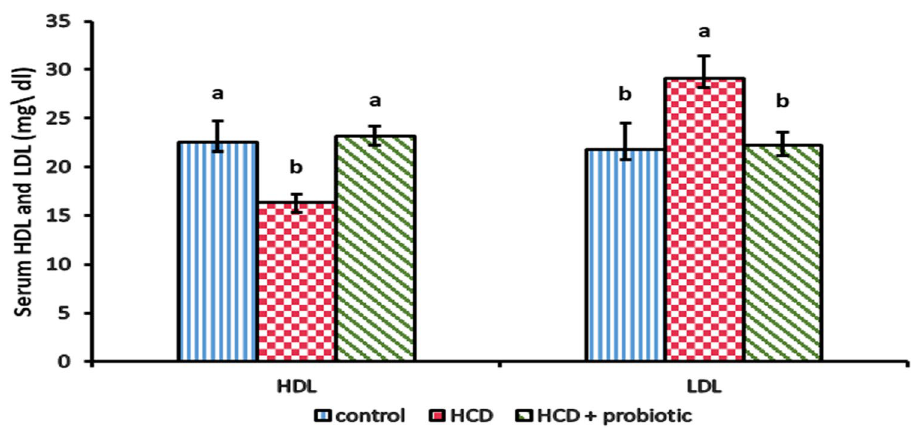
Figure 9. Effect of HCD supplementation and HCD with probiotic on lipid profile [High-Density Lipoprotein (HDL) and low-density lipoprotein (LDL)].